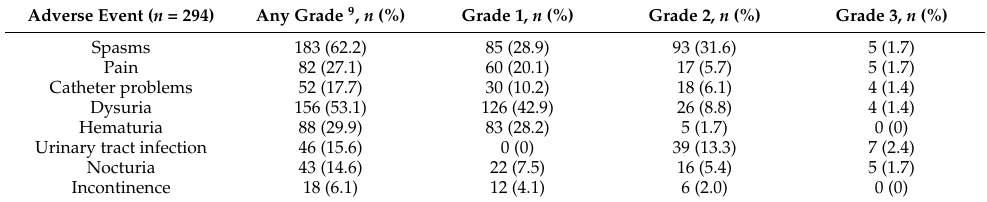
Table 6. Adverse